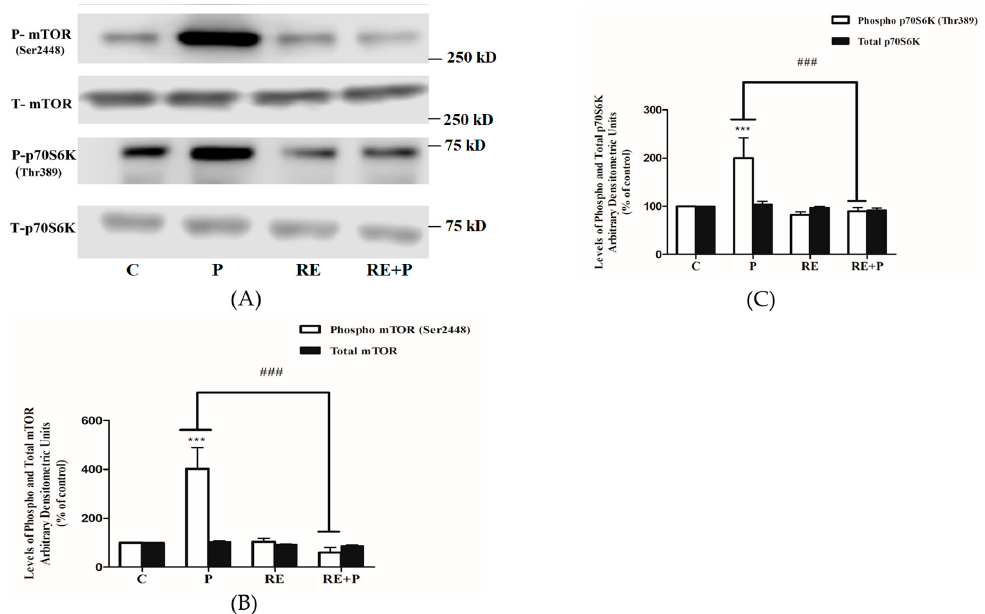
Figure 6. Effects of palmitate and RE on mTOR and p70 S6K expression and phosphorylation. Fully differentiated myotubes were treated without (control, C) or with 0.2 mM palmitate (P) for 16 h in the absence or the presence of 5 μ g/mL RE. After treatment, the cells were lysed, and SDS-PAGE was performed, followed by immunoblotting with specific antibodies that recognize phosphorylated Ser2448 or total mTOR or phosphorylated Thr389 or total p70 S6K. Representative immunoblots are shown ( A ). The densitometry of the bands was measured and expressed in arbitrary units ( B , C ). The data are the mean ± SE of three separate experiments (*** p < 0.001 vs. control, ### p < 0.001 vs. palmitate